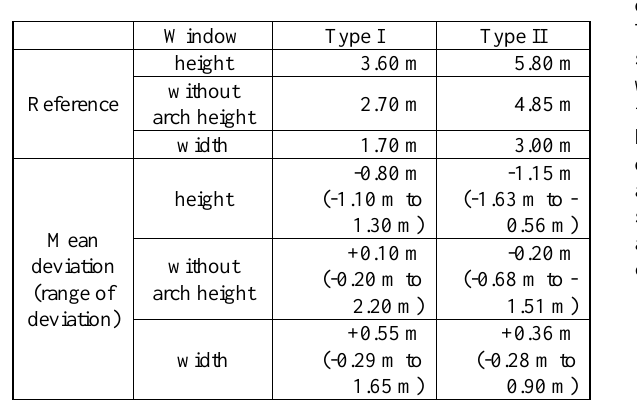
Table 2. Evaluation of window size (arch windows)